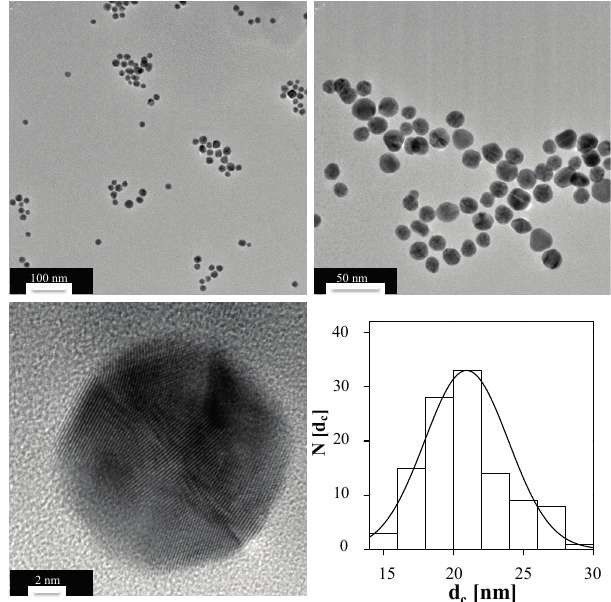
Figure 1. TEM images of the Au NPs at different magnifications (scale bars corresponding to 100 nm, 50 nm and 2 nm), and the corresponding histogram N ( d c ) of the core diameter d c